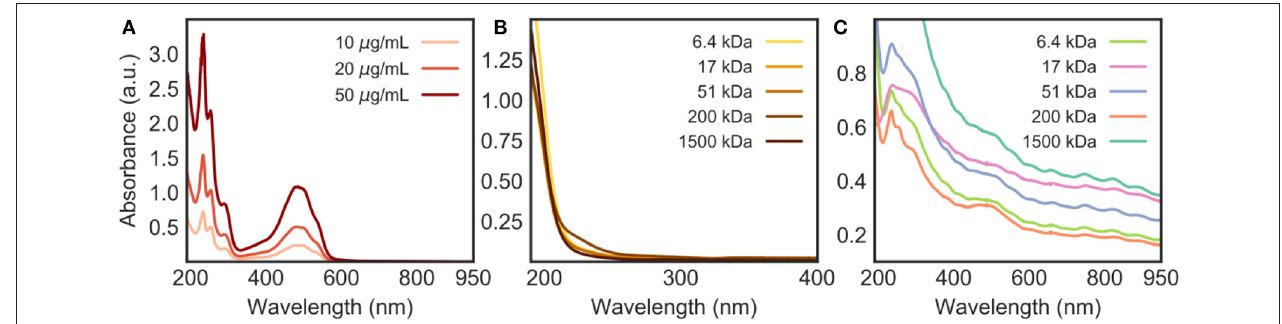
FIGURE 5 | UV-Vis absorption spectra in water of (A) DOX at various concentrations (10, 20 and 50 µ g/mL); (B) HA-DMPE (50 µ g/mL); and (C) DOX/CNT/HA-DMPE (10 µ g/mL). Materials involving HA were analyzed at various chain lengths (6.4, 17, 51, 200, and 1,500 kDa).